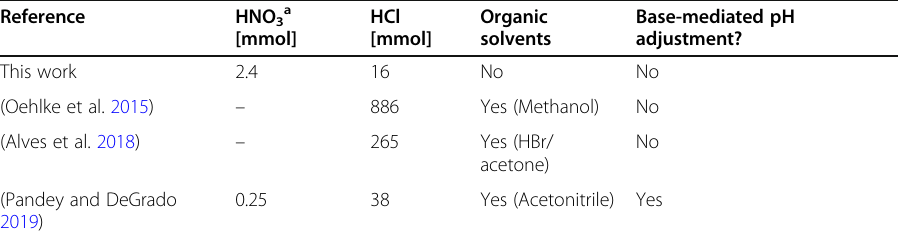
Table 2 Comparison of FASTlab [ 68 Ga]GaCl 3 purification vs. recent literature